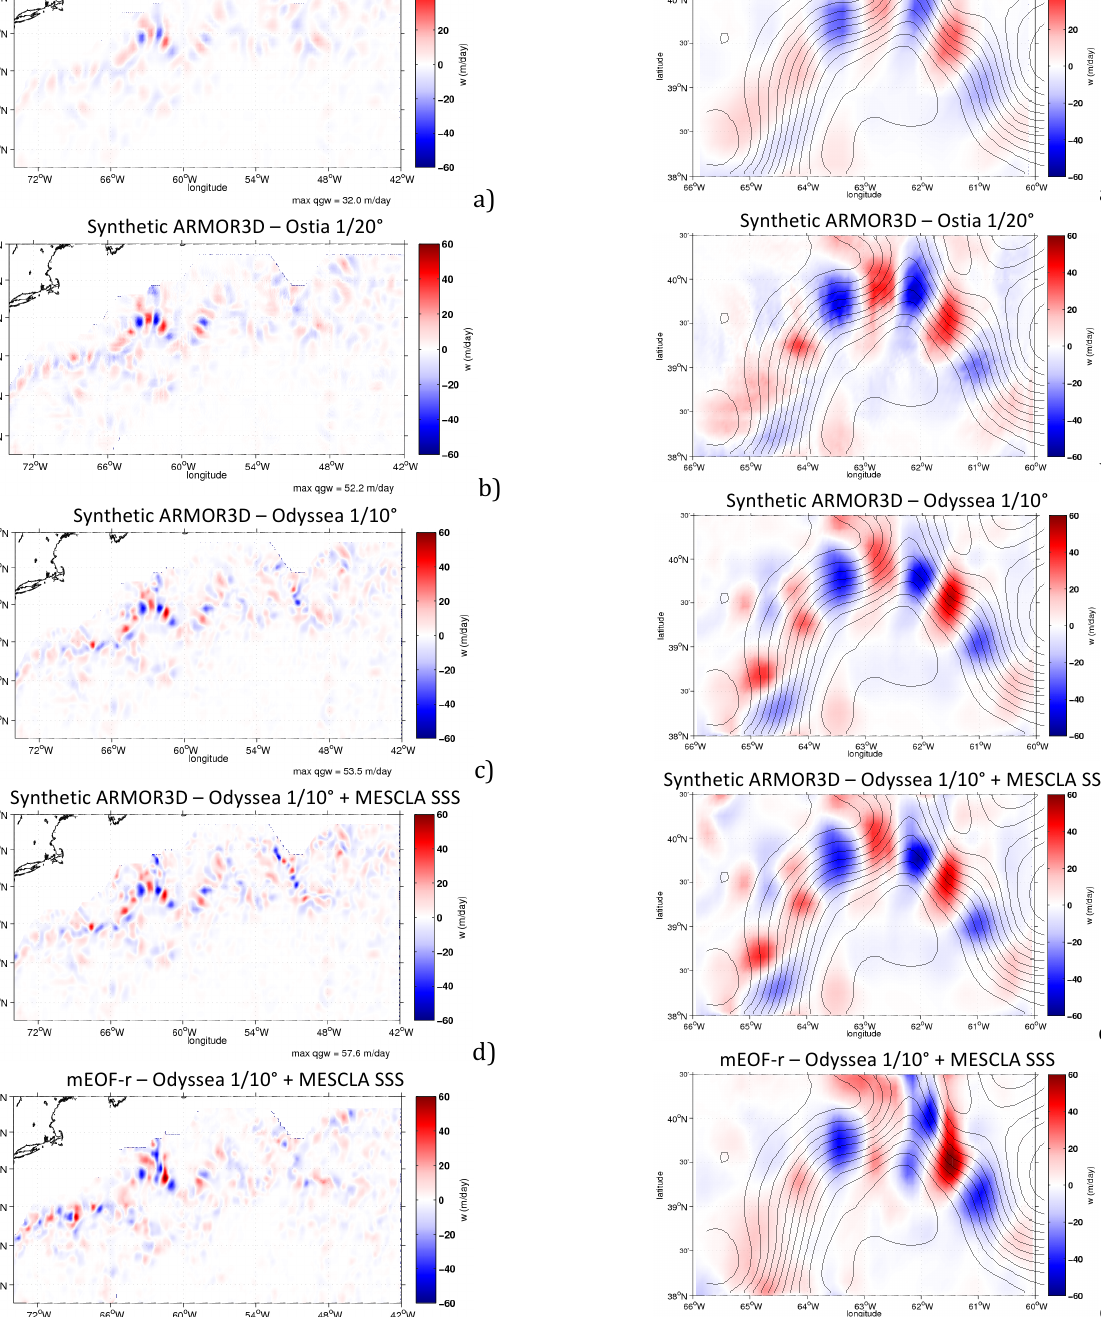
Fig. 14. Zoom of the QG vertical velocity fields at 100m as retrieved from the tem- peratureandsalinityfieldsreconstructedthroughtheselectedmethods: (a) ARMOR3D using Reynolds L4 SST as input, (b) ARMOR3D using OSTIA L4 SST as input, (c) ARMOR3D using ODYSSEA L4 SST as input, (d) ARMOR3D using ODYSSEA L4 SST and MESCLA SSS as input, and (e) mEOF-r( T - S -SH) SSS-SSH for the salinity field and mEOF-r( T - S -SH) SST-SSH for the temperature. SSH isolines are superim- posed to allow the identification of meanders’ crests and